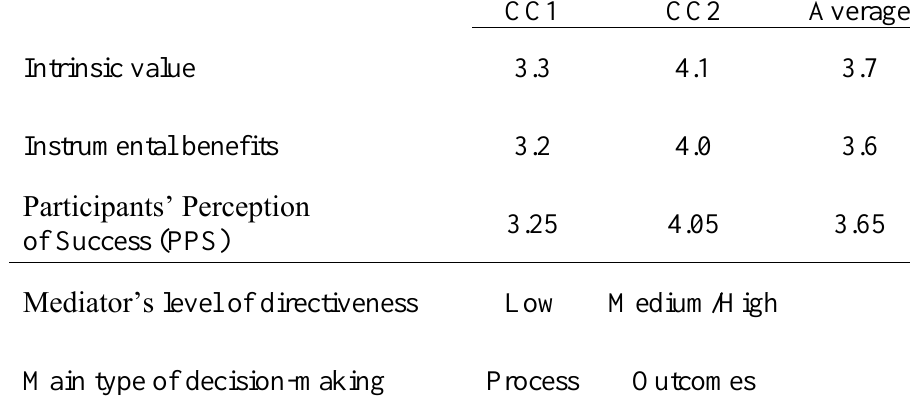
Participants’ Perception of Success (PPS) and Mediation